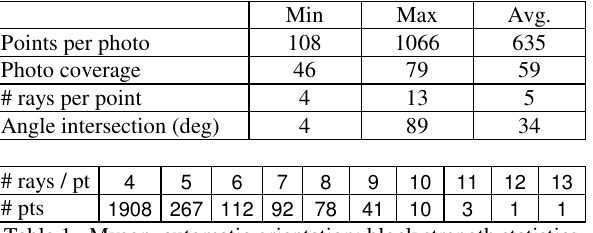
Table 1. Myson, automatic orientation: block strength statistics The minimum number of points occurs at the left hand side of the sequence, because only the first four images look to that side of the building; besides, the wooden frame cause